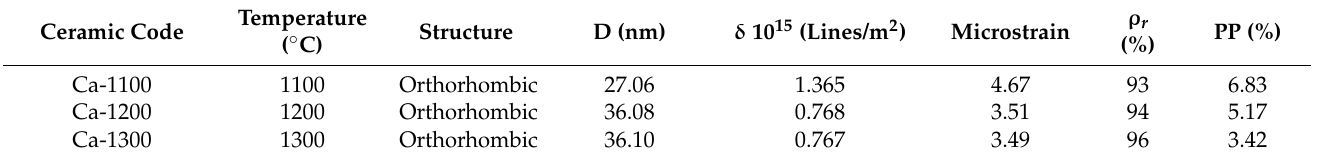
Table 1. Ceramic code, crystal structure, crystallite size, relative density, and porosity percentage of as-prepared